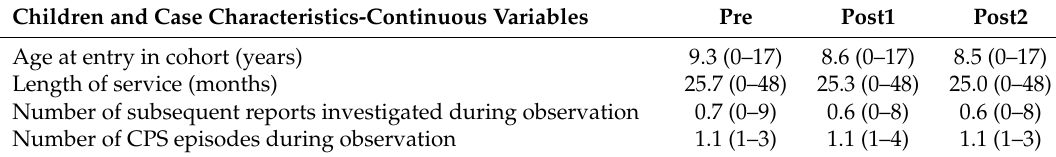
Table 3. Children and case characteristics—Continuous